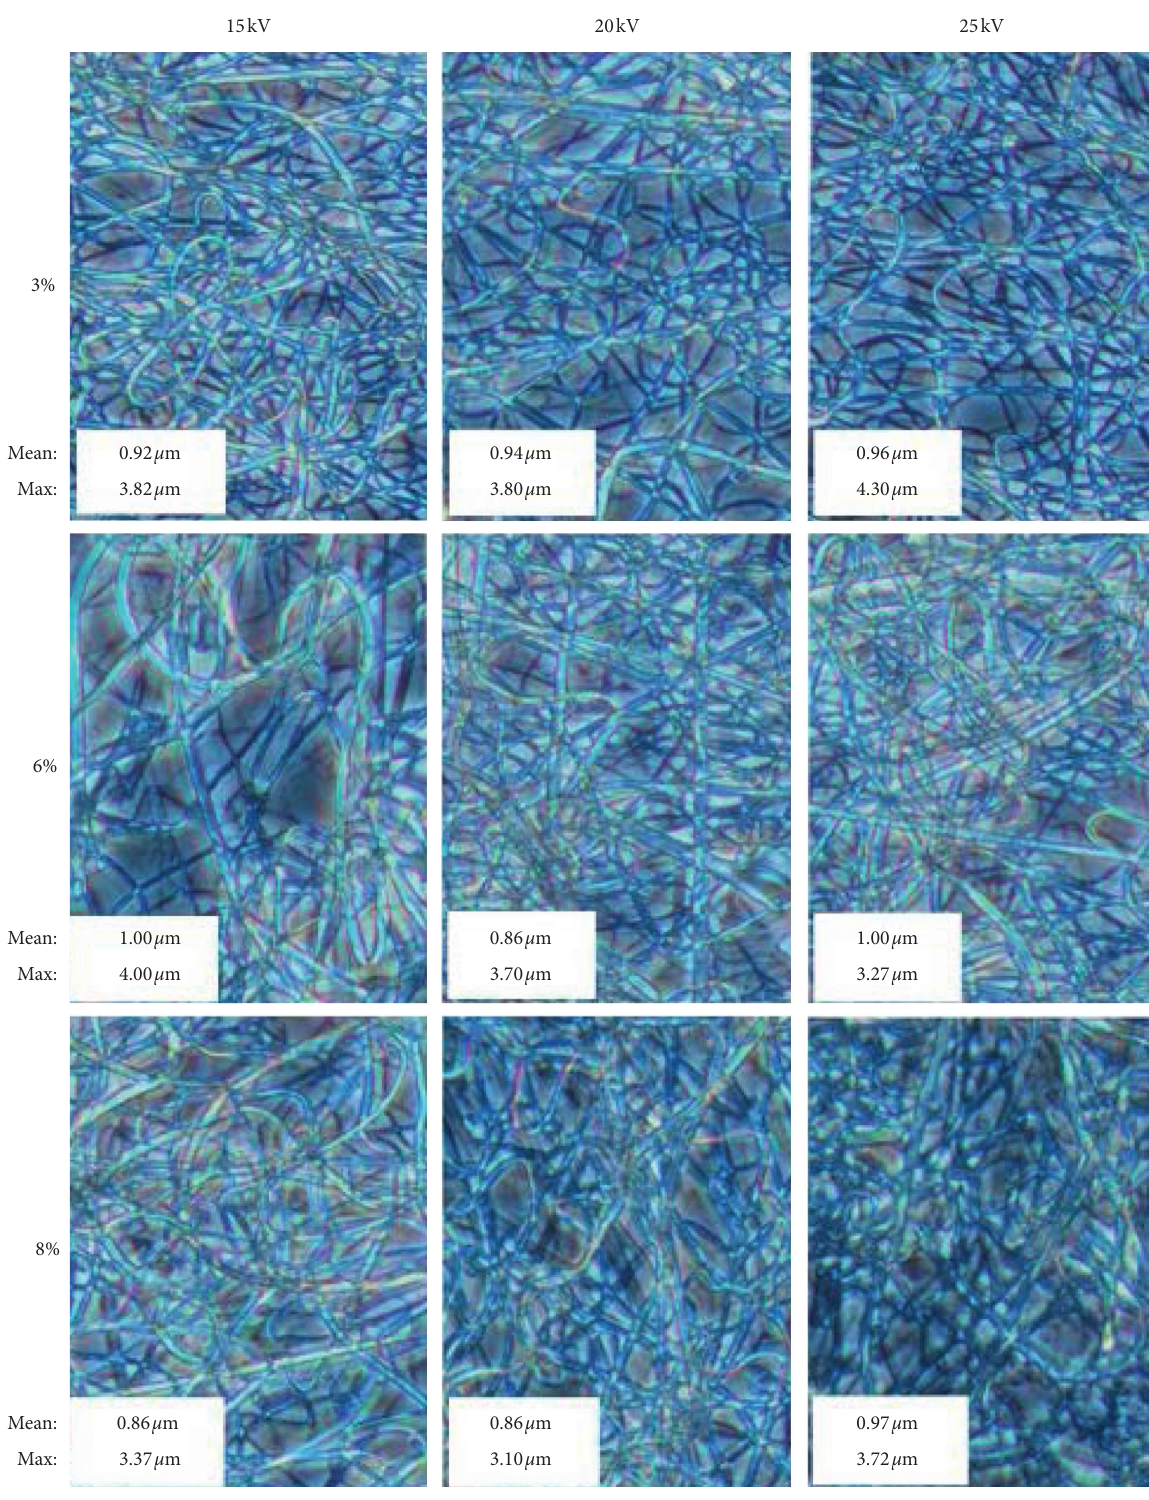
Figure 2: Light microscopy images of different concentrations of collagen dissolved in HFIP to prepare 3, 6, and 8% w/v polymer solutions after electrospinning under different voltages of 15–25